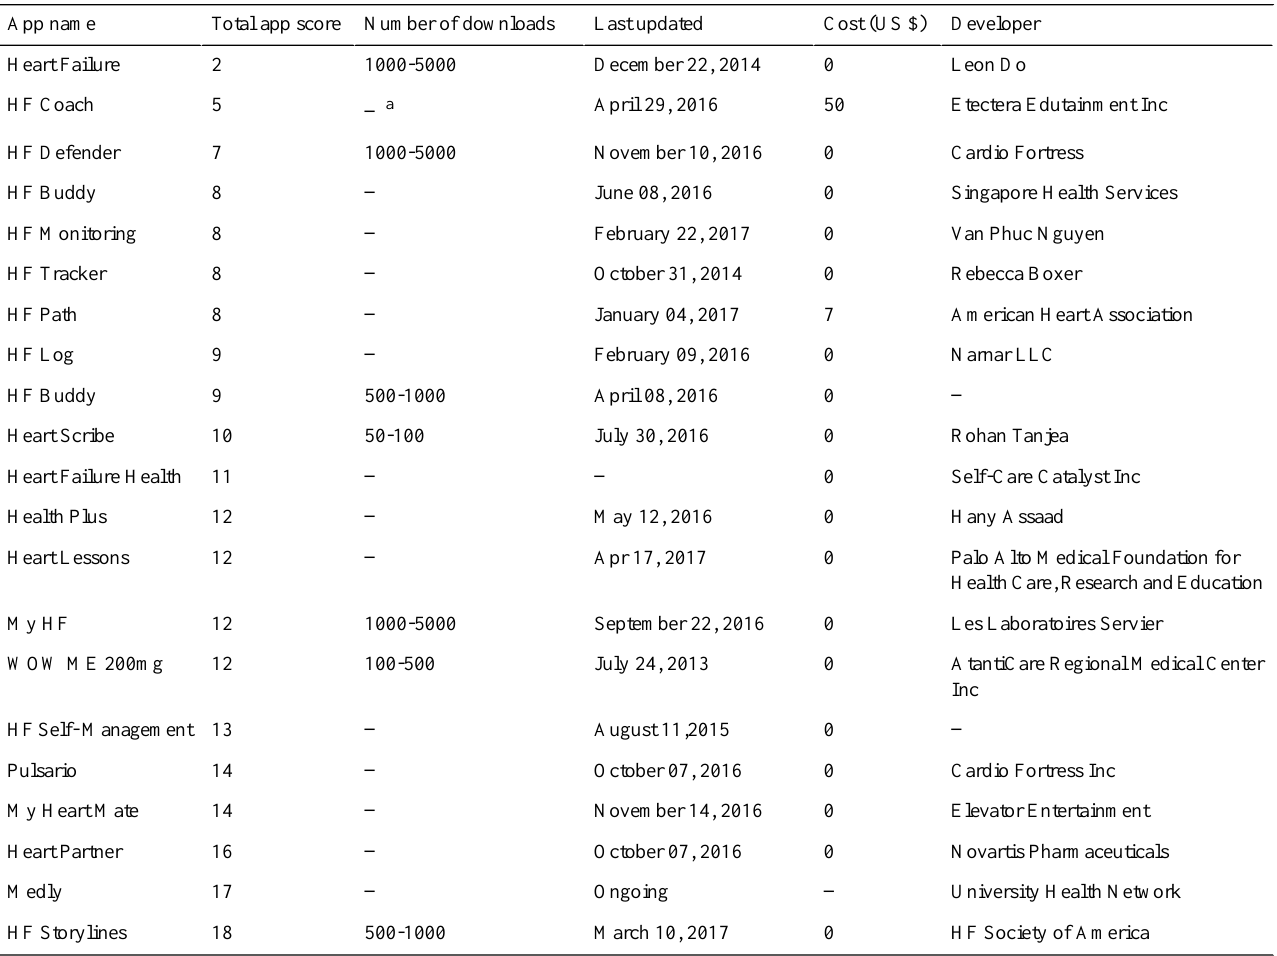
Table 4. Total score of the filtered heart failure self-care apps and their corresponding number of downloads, last updates, and cost